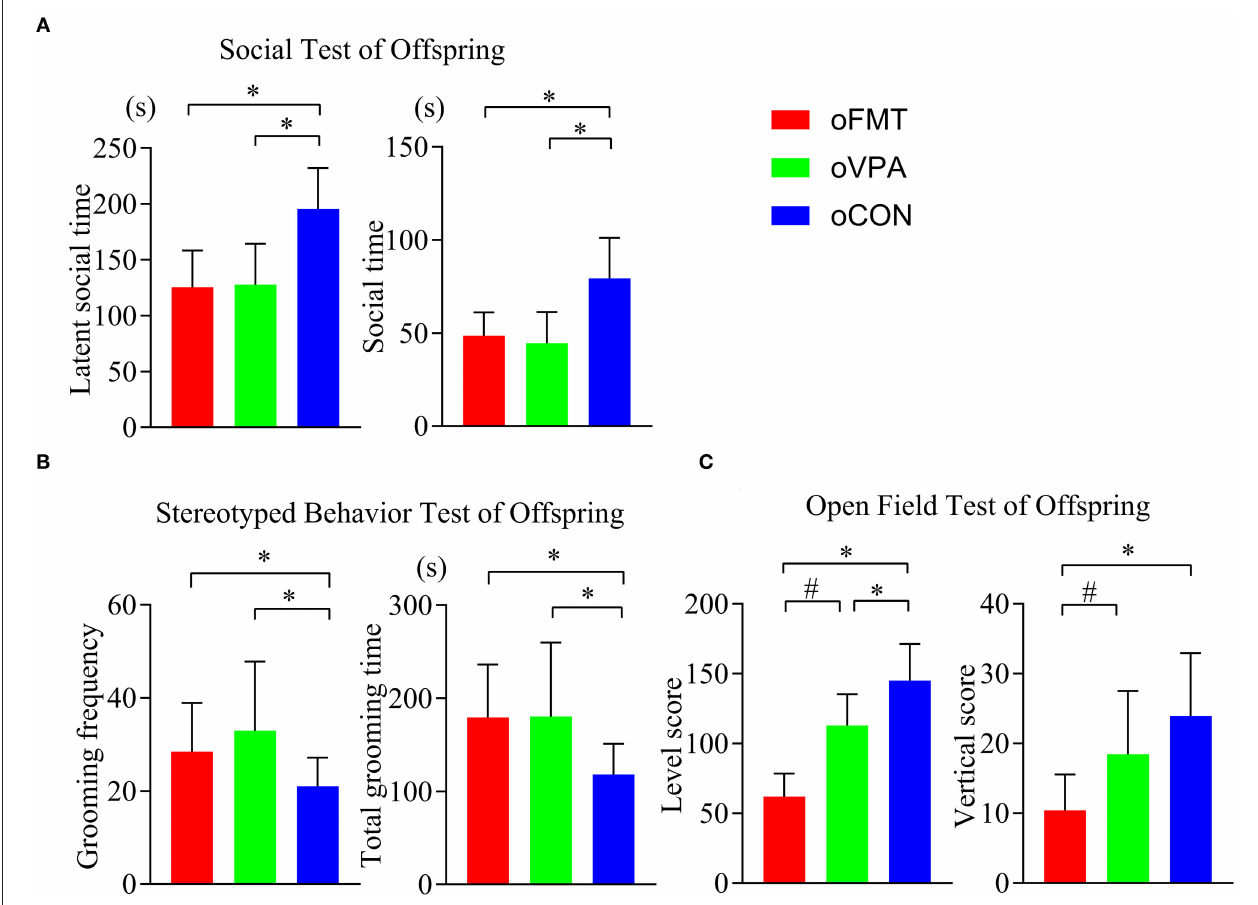
FIGURE 2 | Impact of FMT on behavioral phenotypes and indicators in offspring rats. (red: oFMT; green: oVPA; blue: oCON). “* P < 0.05” compare with the oCON, “ # P < 0.05” indicates compare with the oVPA. (A) Social behaviors test ( n = 30, each group). (B) . Stereotypical behaviors test ( n = 32, each group). (C) . Open filed test ( n = 20, each group). More than two animals were used in each litter and mixed with effective models for analysis. In other words, non-test experimenters selected rats from each litter by random number table method, and mixed the rats of each group. Finally, we conducted a behavioral test and statistical